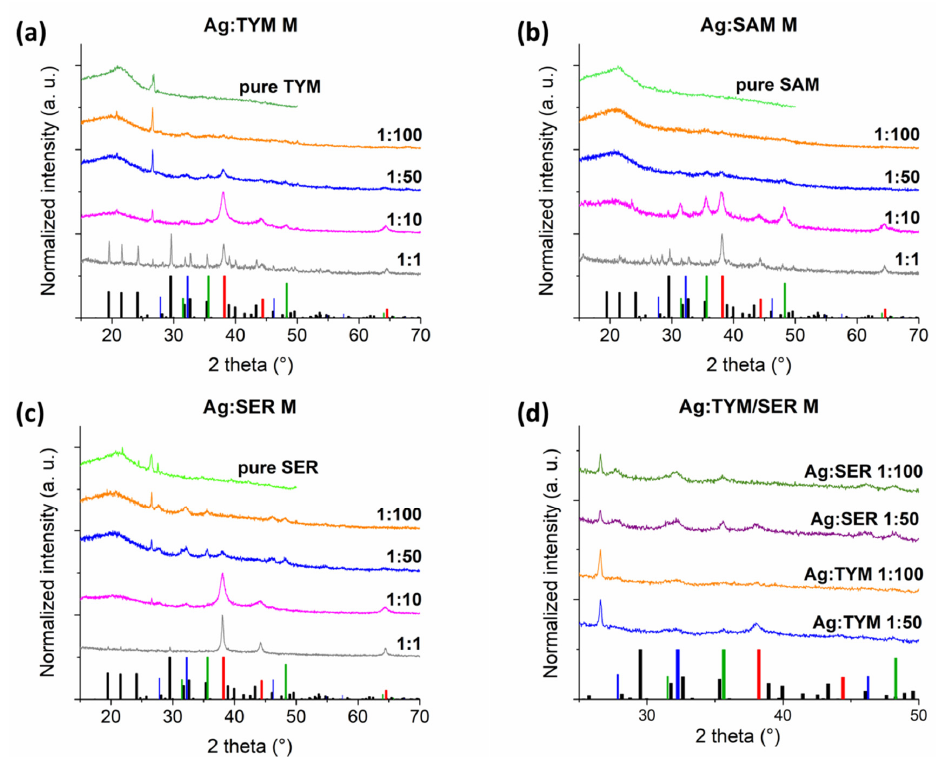
Figure 1. XRD patterns of AgNPs embedded in the plant matrix and that of the pure plants after milling; ( a ) Ag:TYM M; ( b ) Ag:SAM M; ( c ) Ag:SER M; ( d ) the zoomed region between 27° and 50° for the TYM- and SER-rich M samples (bars at the bottom refer to XRD of ICDD PDF2 database: AgNO 3 (black, 074-2076), Ag (red, 65-2871), WC (green, 51-0939) and AgCl (blue, 71-5209)).